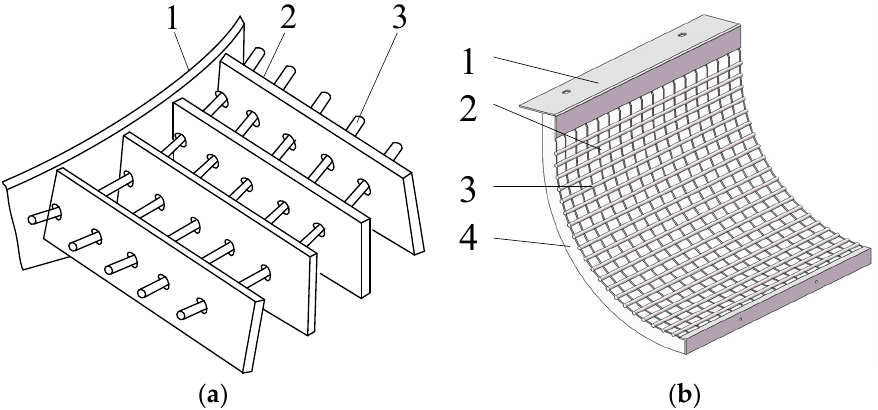
Figure 4. ( a ) Schematic diagram of a concave grid sieve: 1. side arc plate; 2. diaphragm; 3. sieve bar; ( b ) Schematic diagram of the round tubular concave plate sieve: 1. gravure mounting plate; 2. grid plate; 3. round tube; 4. side arc plate.